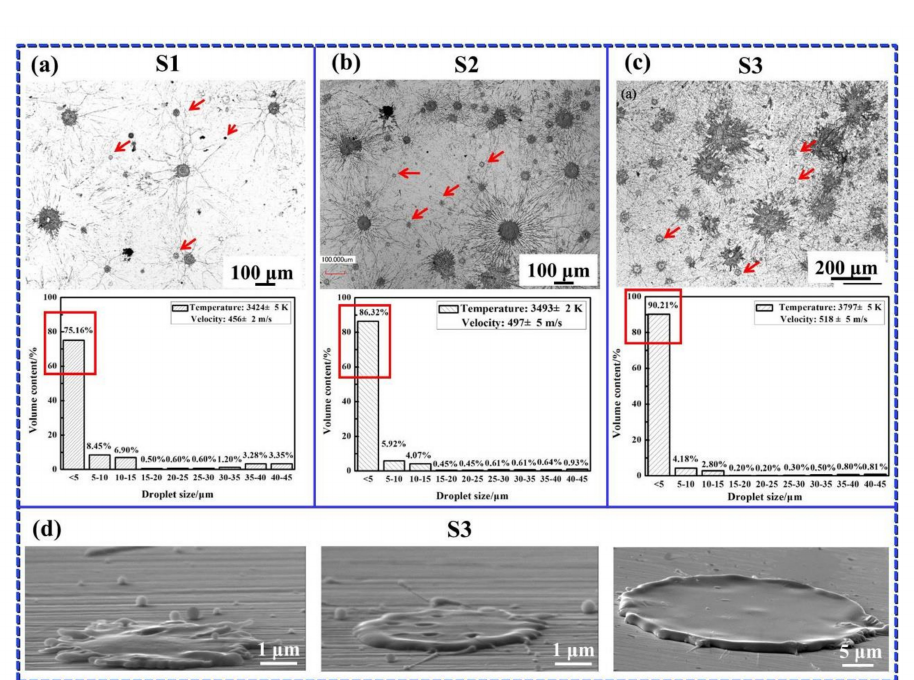
Figure 4. Morphology and percentage of splats at di ff erent in-flight behavior: ( a ) S1; ( b ) S2; ( c ) S3; ( d ) high-magnification images of refinement S3